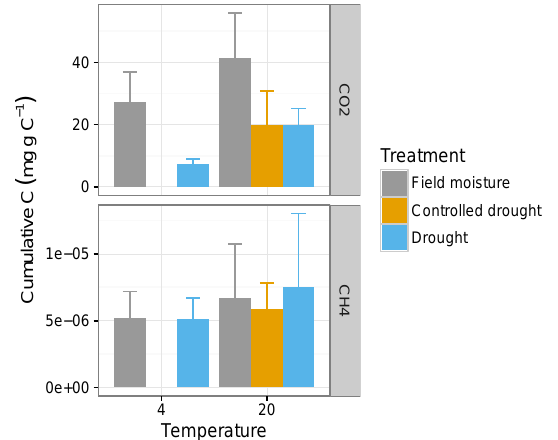
Figure 4. Cumulative mass-normalized C fluxes (mggC − 1 ) over the incubation by gas (CO 2 and CH 4 , top and bottom panels, re- spectively), treatment (columns), and temperature ( x axis, ◦ C). Let- ters within a panel indicate significant differences based on Tukey’s